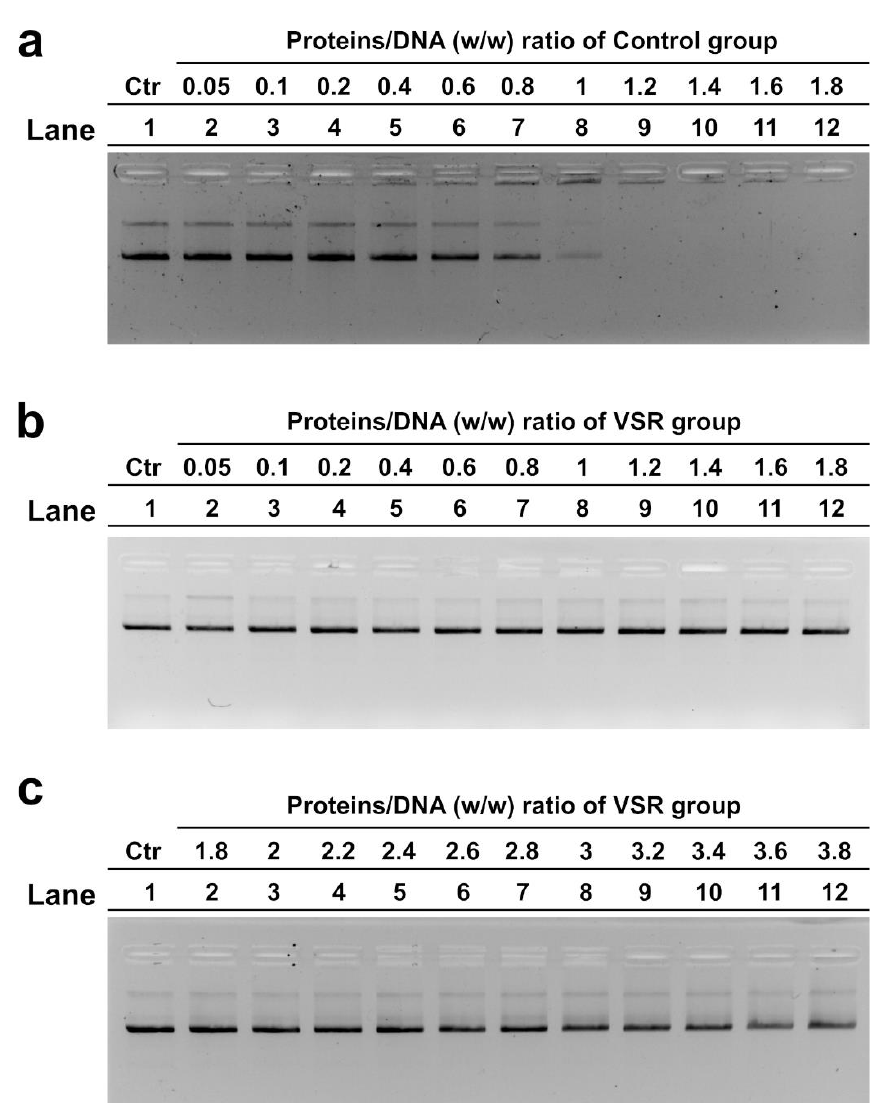
Figure 7. DNA-binding ability of SNBPs obtained from control group ( a ) and VSR group ( b , c ) analyzed by electrophoretic mobility shift assay (EMSA) on 1% agarose gel. Bands on gel representing the state of pGEM3 plasmid DNA incubated in a ratio w/w with increasing amount of SNBPs from samples. VSR: Valley of Sacco River; control: Valley of Sele River.